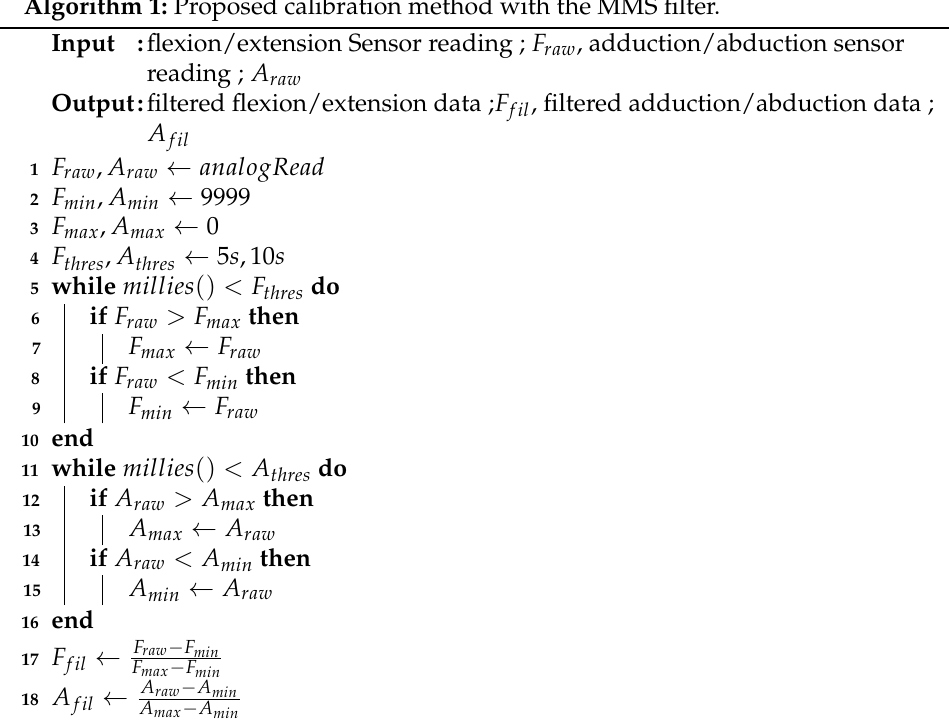
Algorithm 1: Proposed calibration method with the MMS